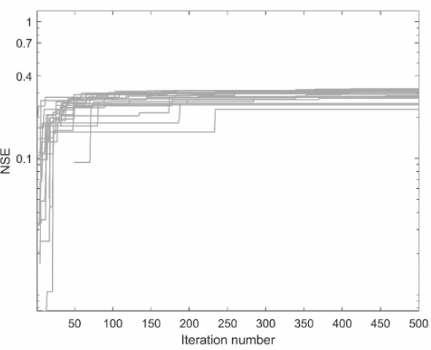
Figure 6. NSE of each iteration step with DE-MC 20 chains for real case study.